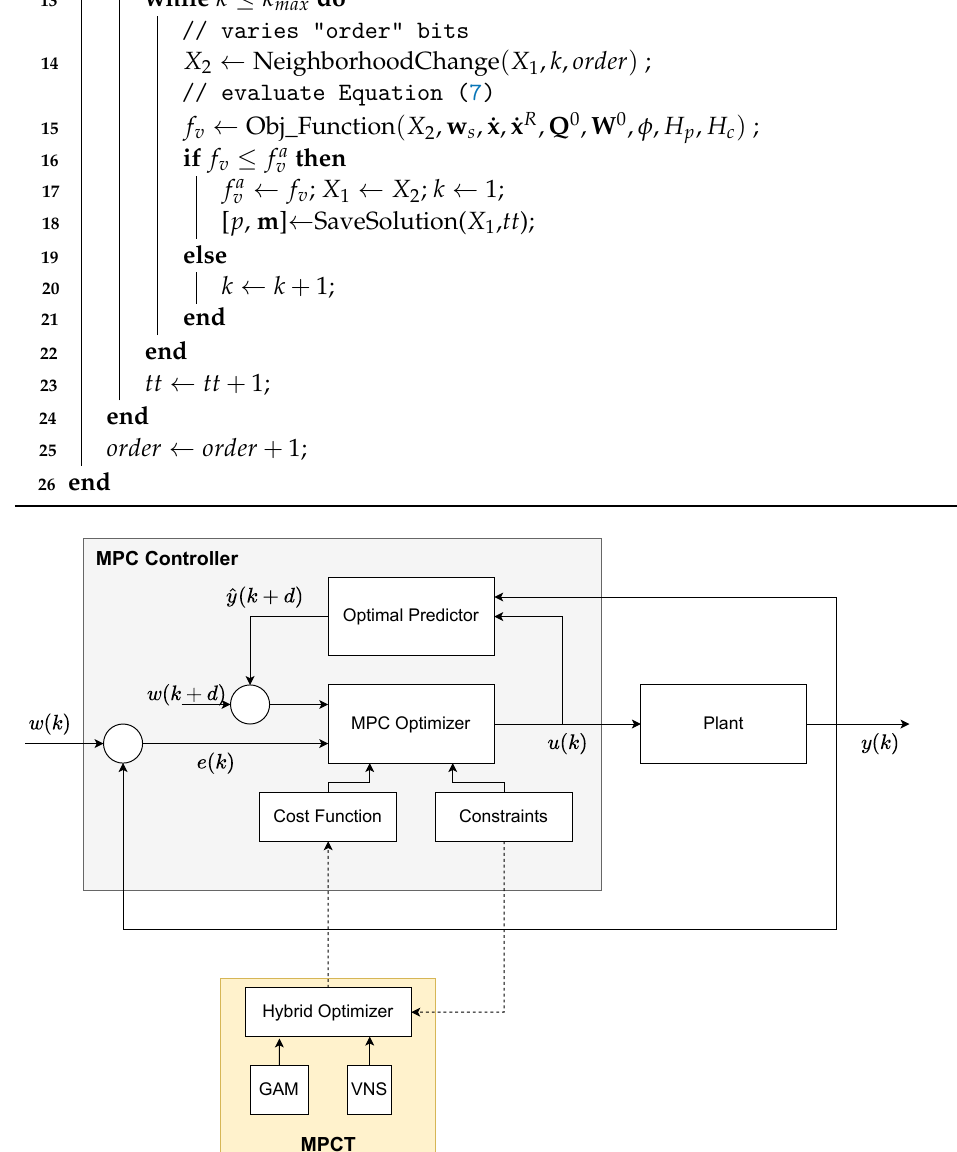
Figure 5. MPC + MPCT